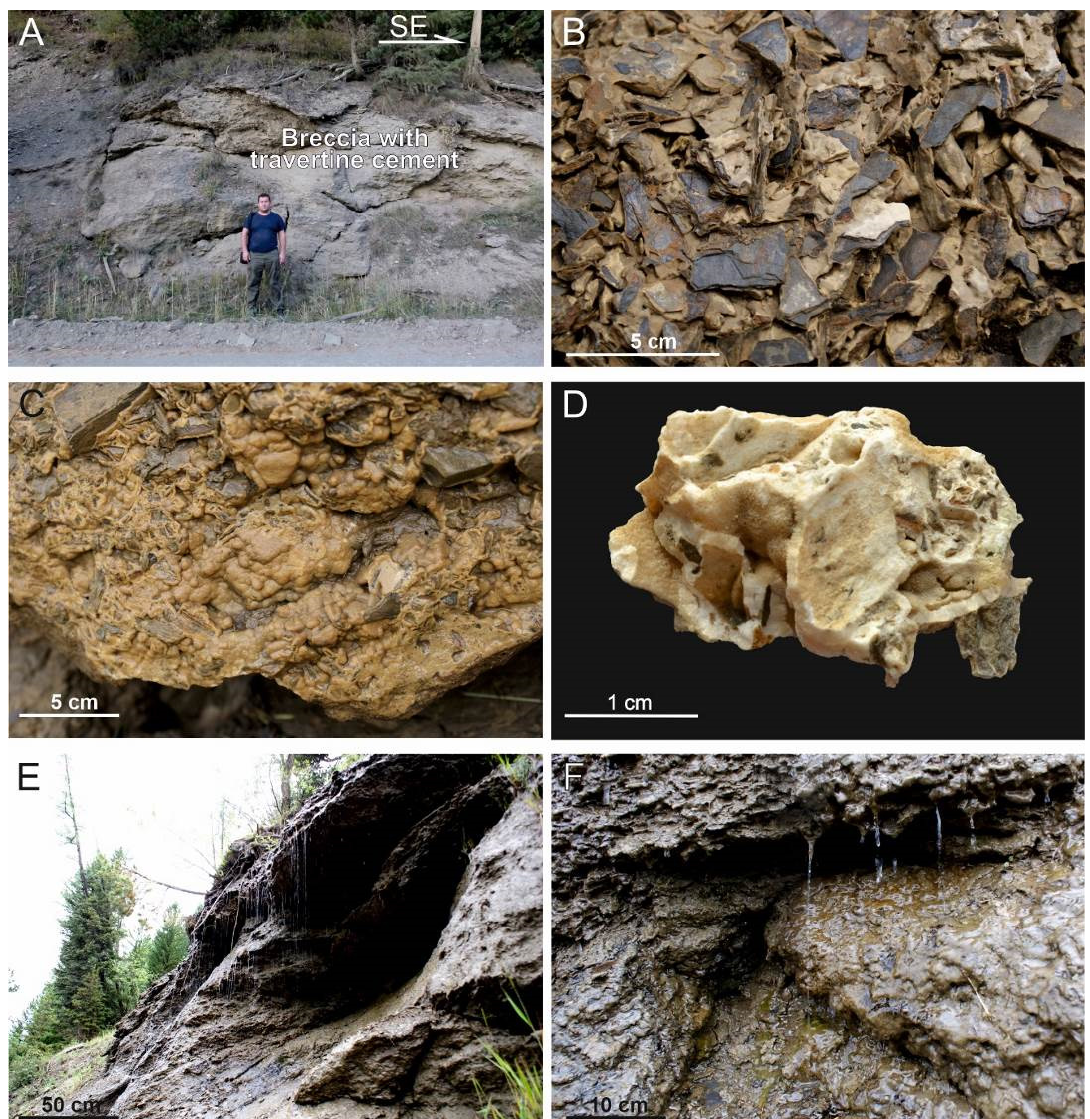
Figure 4. The Cheybek-Kohl 2 travertines. ( A ) Outcrop of breccia with travertine cement. ( B , C ) Close-ups: breccia with travertine cement. ( D ) Travertine crusts lining the inter-clast space. ( E , F ) Carbonate crusts covered with algae precipitating in the present seepage zone.